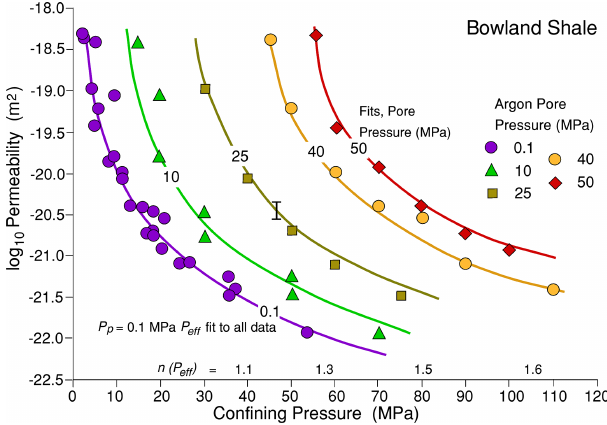
Figure 12. Permeability of Bowland shale versus total confining pressure for various values of constant gas pore pressure. The curve and data shown for P p = 0 . 1 are the effective pressure fit to all the data as shown in Fig. 3, collapsed onto a single least-squares best- fit curve (log 10 k = − 0 . 503log 10 P eff − 17 . 26) for a pore pressure coefficient made to vary linearly with Terzaghi effective pressure according to n = (1 + P eff (MPa) / 85). Measured data for the sepa- rate pore pressures are shown, with best-fit curves with the variable pore pressure coefficient. n values are shown to indicate how they increase from left to